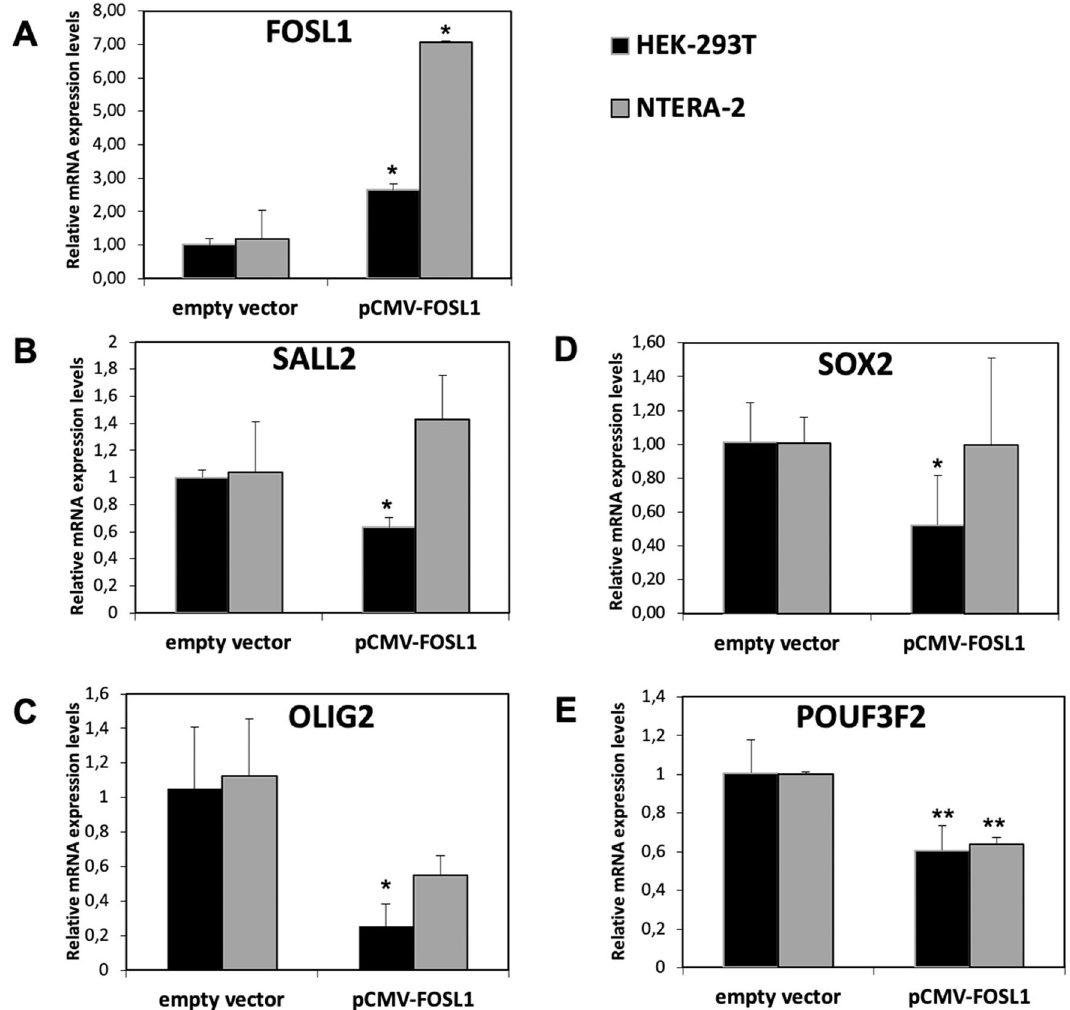
Figure 2. Gene expression analysis of FOSL1 in overexpressed cells. Relative expression levels of FOSL1 ( A ), SALL2 ( B ), OLIG2 ( C ), SOX2 ( D ), and PUO3F2 ( E ) in NTERA-2 and HEK293T cells lines after 48 h from transfection with the empty vector or pCMV-FOSL1 vector. Data are presented as mean and standard deviation of the relative expression of each target using the GAPDH as housekeeping gene and the empty vector as calibrator. p value < 0.05, *; 0.005 **; 0.0005 *** (t-test